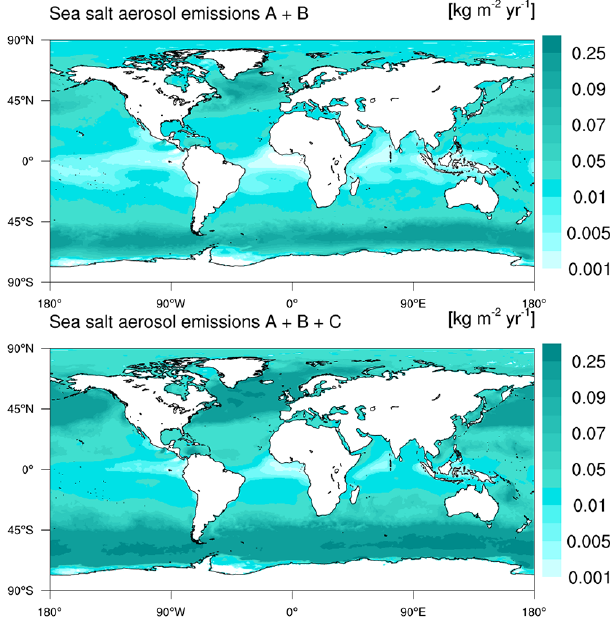
Figure 10. Horizontal distribution of the mass production rate of sea-salt aerosol in kgm − 2 yr − 1 . Top: only modes A and B are con- sidered to be comparable to Grythe et al. (2014). Bottom: sum of all three modes, A, B and